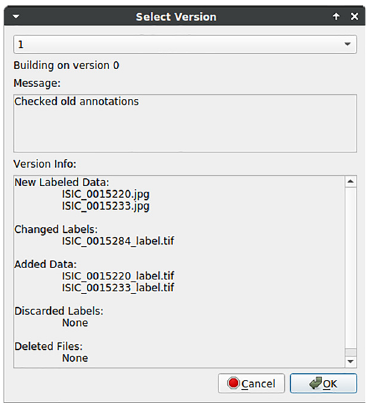
Figure 11: Feedback of data version control to users. Changes in the dataset are listed to give feedback to users regarding different dataset